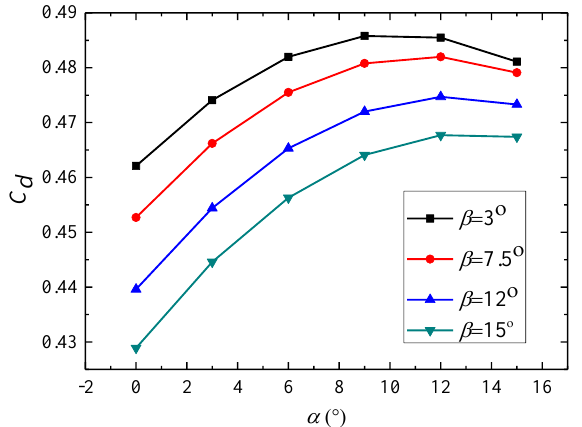
Figure 7. Influences of fin expansion angle on discharge coefficient. ( w = 0.4 mm, c = 0.4 mm, H = 5 mm, B = 6 mm)